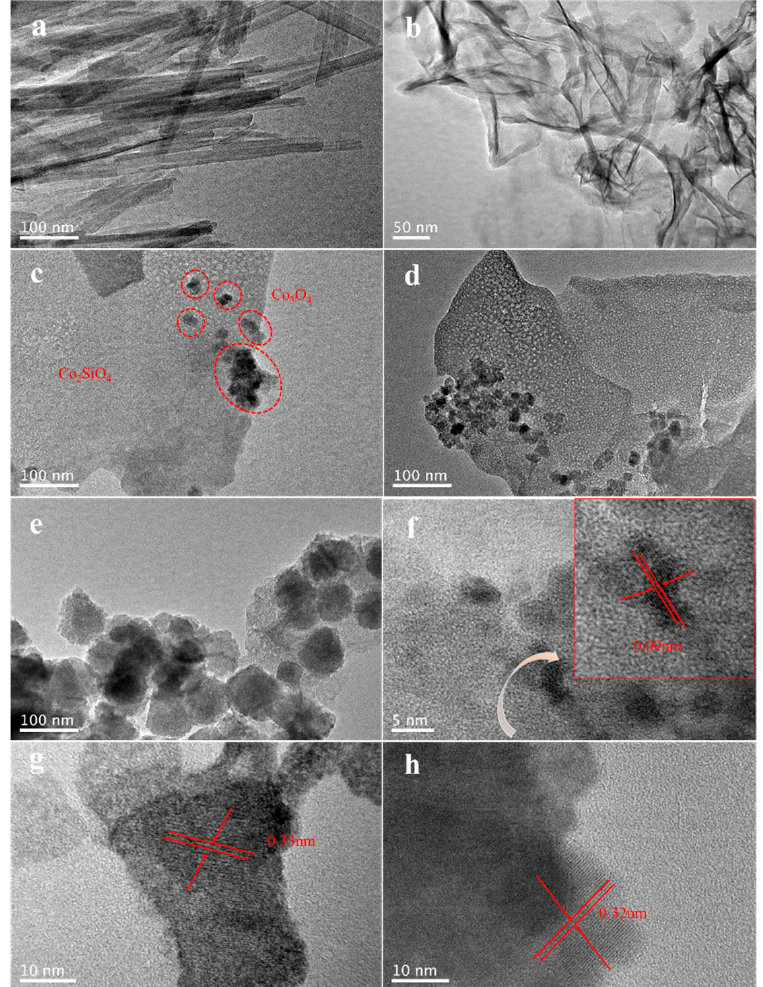
Figure 2. TEM images of ( a ) Pal, ( b ) Co 2 SiO 4 , ( c ) Co 2 SiO 4 /Co 3 O 4 − 1%, ( d ) Co 2 SiO 4 /Co 3 O 4 − 5%, and ( e ) Co 2 SiO 4 /Co 3 O 4 − 10%. Corresponding HRTEM images of ( f ) Co 2 SiO 4 , ( g ) Co 2 SiO 4 /Co 3 O 4 − 1%, and ( h ) Co 2 SiO 4 /Co 3 O 4 − 5%.